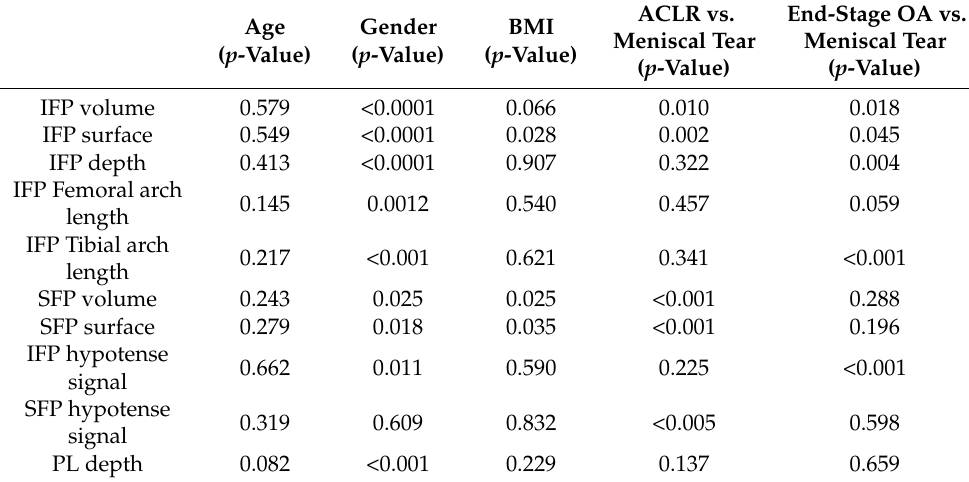
Table 5. General linear